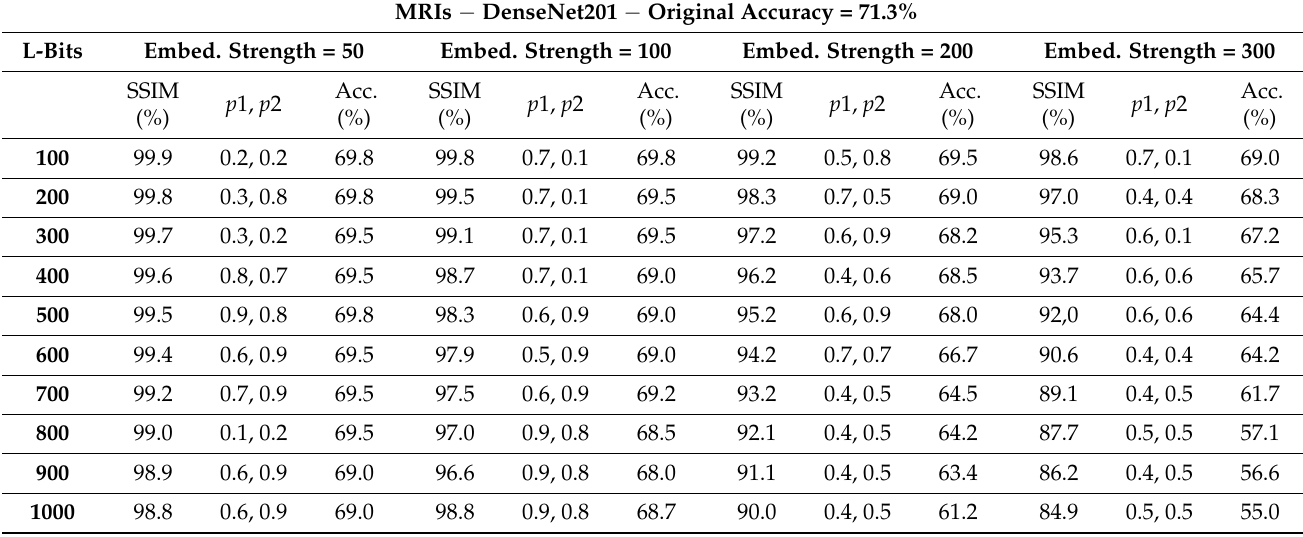
Table A2. KMsWA 2 attack on DenseNet201 in